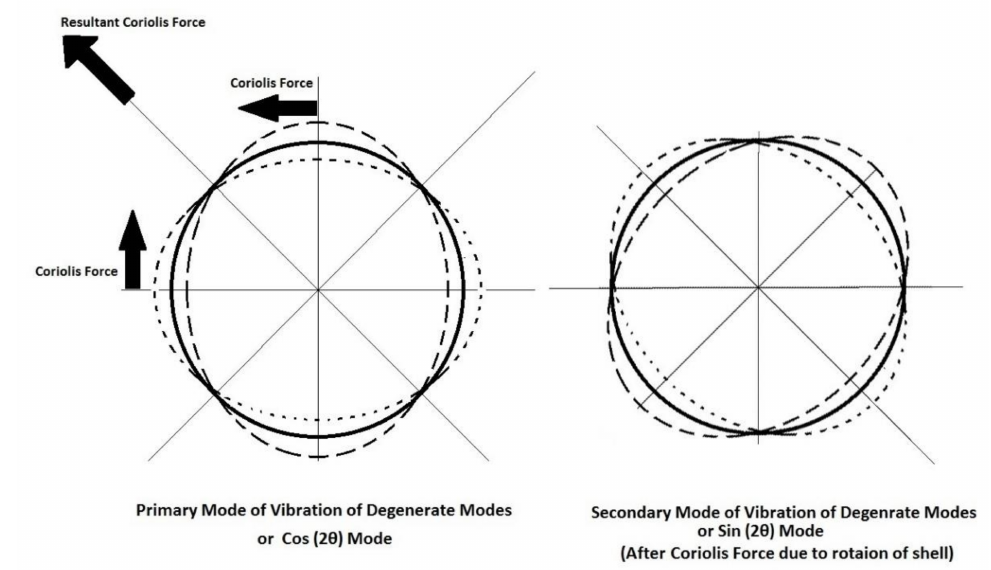
Figure 2. Degenerate modes of vibration of hemispherical shell in n = 2 mode.